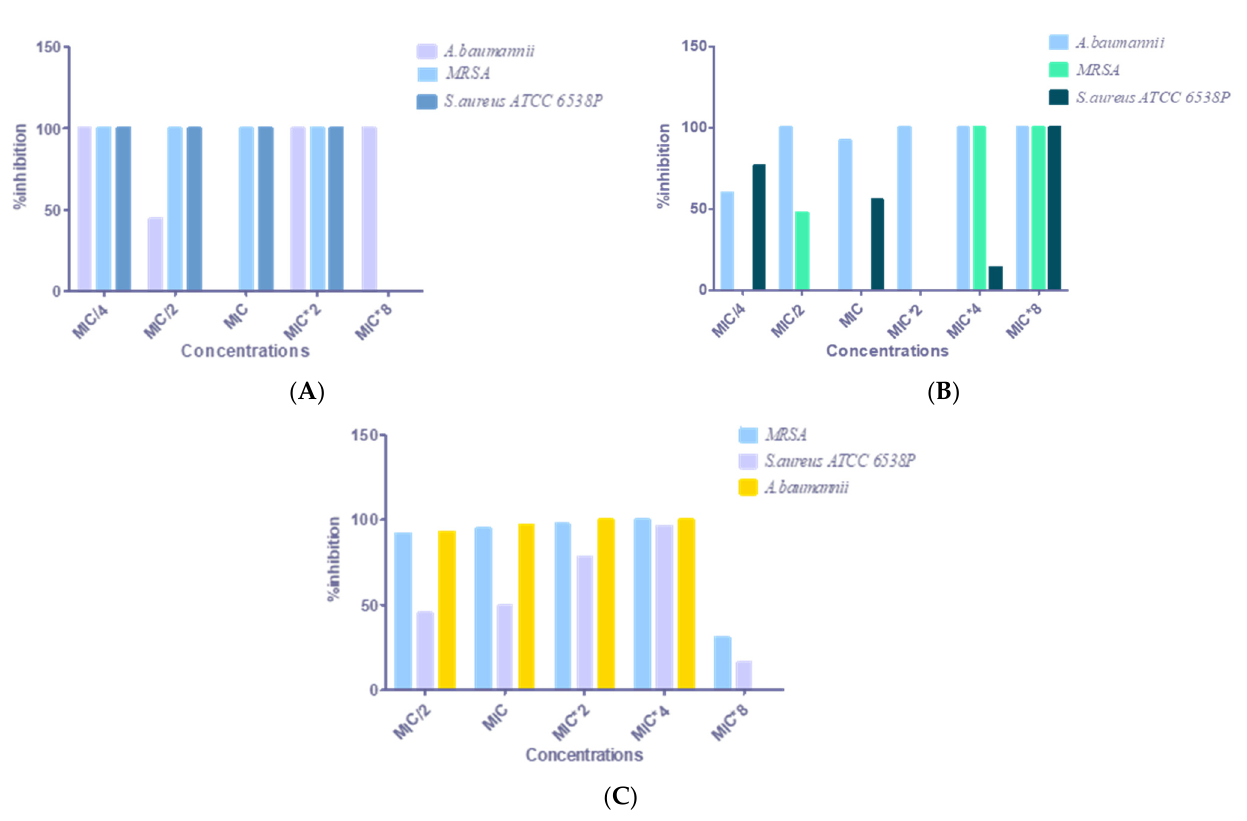
Figure 4. The inhibitory effect of O. glandulosum essential oil and their nanoformulations on biofilm formation by pathogenic bacteria: ( A ) effect of nanoemulsion, ( B ) effect of nanocapsules, and ( C ) effect of HD oil.